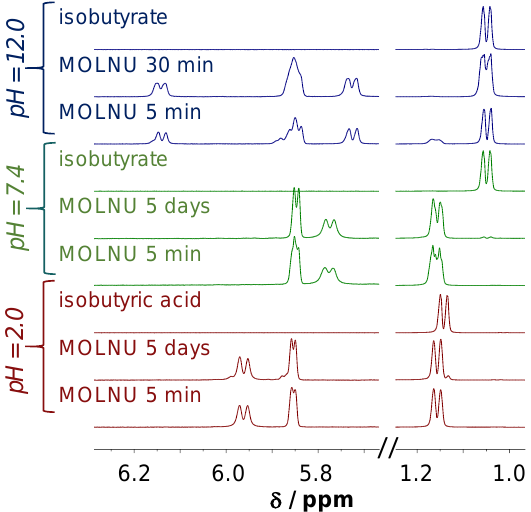
Figure 1. 1 H NMR spectra of MOLNU followed in time (5 min, 30 min, and 5 days) at pH 2.0, 7.4, and 12.0, corresponding spectra of isobutyric acid/isobutyrate are shown as well for comparison [ c MOLNU = 1 mM; 10% ( v / v ) D 2 O/H 2 O; t = 25 °C].